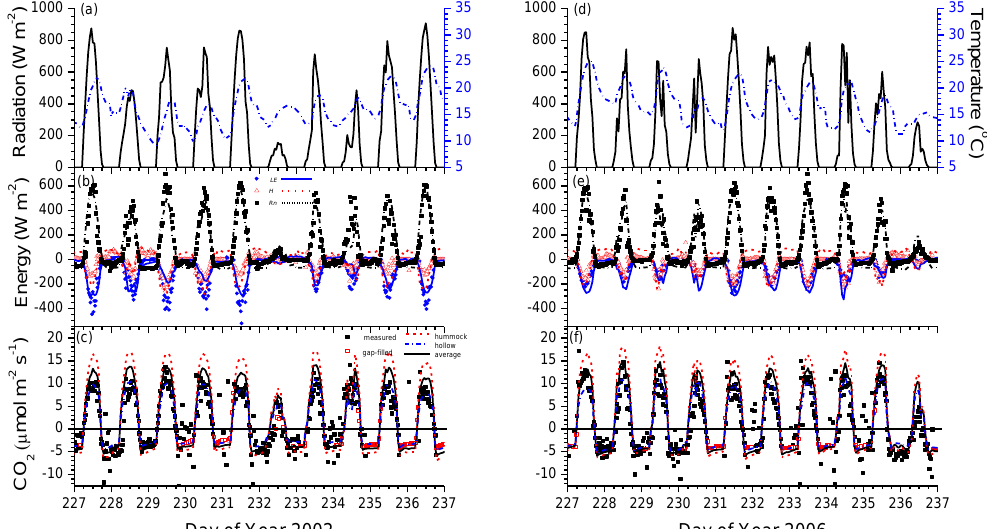
Fig. 4. Radiation and air temperature, energy and CO 2 fluxes measured (symbols) and modelled (lines) from DOY 228 to 237 with high water table in 2002 (0.2m in Fig. 2) and low water table in 2006 (0.7m in Fig. 2). Positive values represent downward fluxes, negative values represent upward